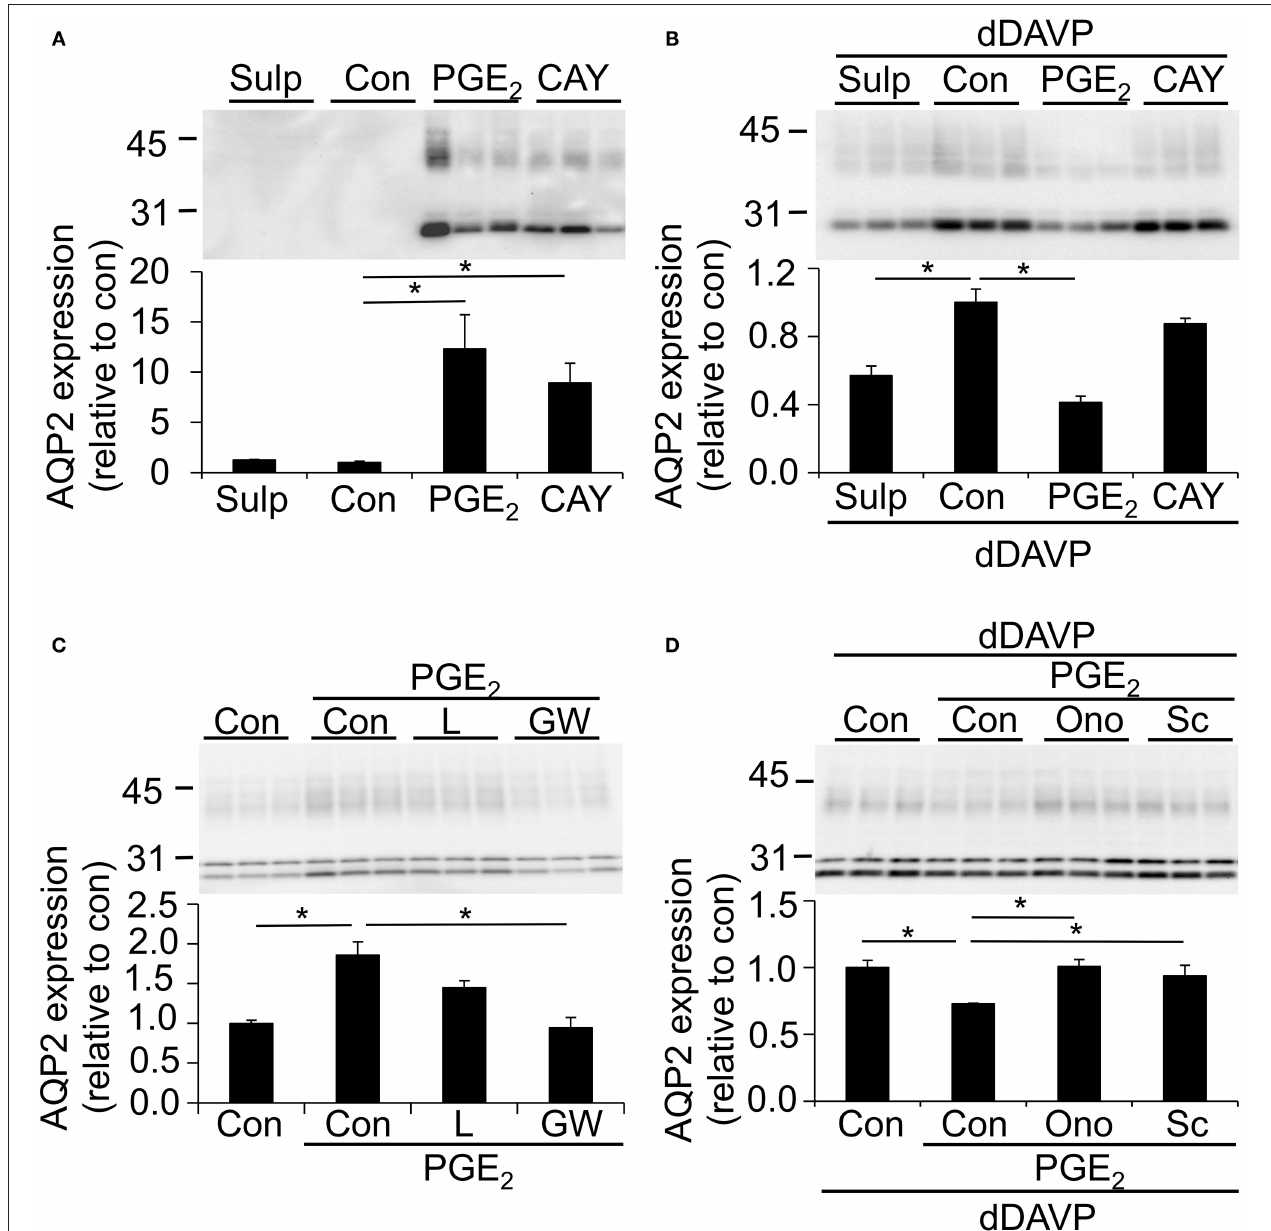
FIGURE 5 | Effect of different PGE 2 receptor agonists and antagonists on the AQP2 expression. MpkCCD c14 cells were grown for 8 days, either with our without 1nM dDAVP stimulation for the last 4 days and with or without 1 µ M PGE 2 during the last 48h. (A,B) Cells were incubated with1 µ M sulprostone (Sulp) or 300nM Cayman10580 (Cay) during the last 48h. (C) Cells were incubated with 0.5 µ M of EP4 antagonist Gw627368 (GW) or 2.5nM of the EP4 antagonist L161982 (L) during the last 48h. (D) Cells were incubated with 20 µ M of EP1 antagonist Sc-51089 (Sc) or 100nM of EP1 antagonist Ono-8711 (Ono) during the last 48h. Cells were lysed and subjected to immunoblotting for AQP2. Molecular masses (in kDa) are indicated on the left. Nonglycosylated AQP2 (29 kDa) and complex-glycosylated (40–45 kDa) forms of AQP2 are detected and densitometrically quantified. Significant differences from control (con, p < 0.05) are indicated by an asterisk. Bars are mean values of 9 (A,B) or 6 (C,D) filters per condition ( ± SEM).